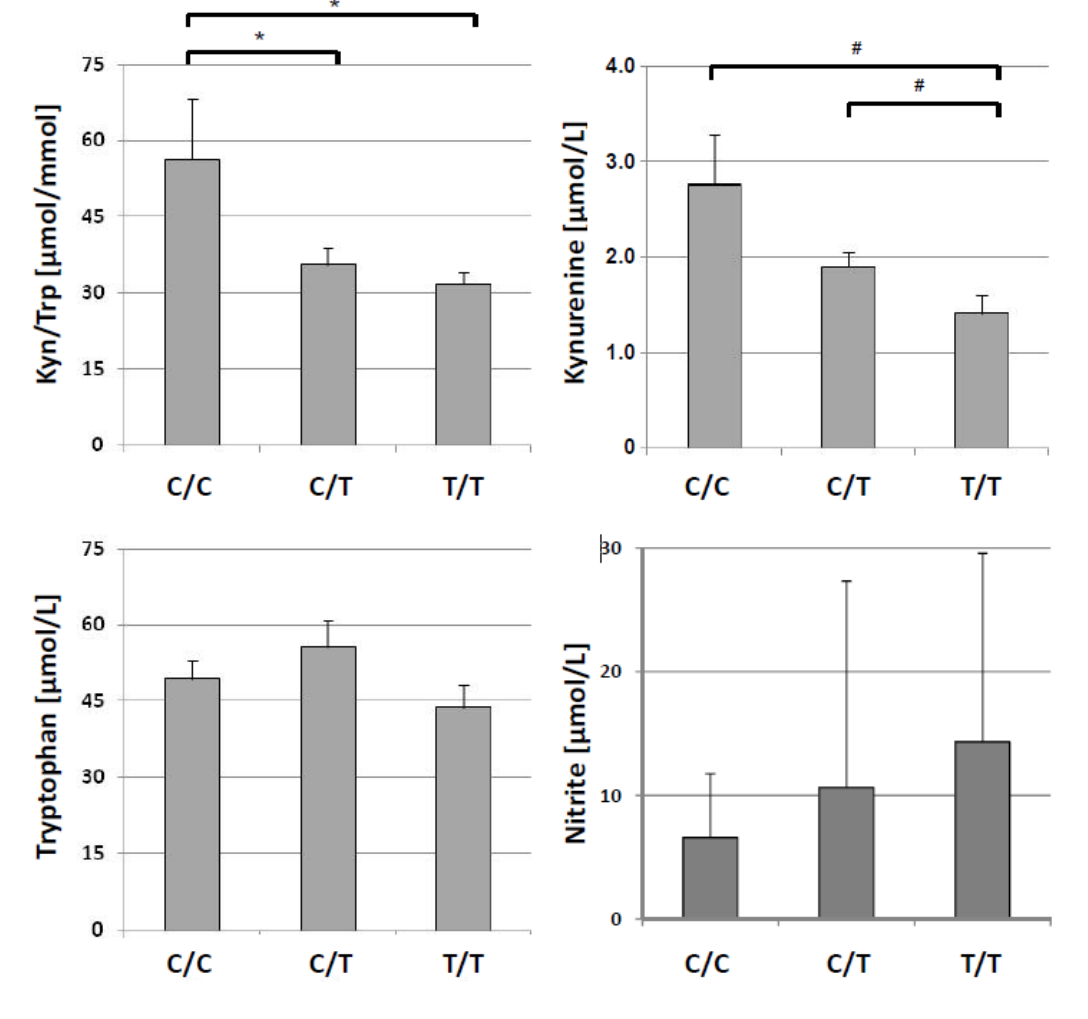
Figure 1. Distribution of concentrations of kynurenine to tryptophan (KYN/TRP, upper left) kynurenine ( upper right ), tryptophan ( lower left ) and nitrite ( lower right ) concentrations in patients with HCV infection split into 3 groups according to IL28B genotypes C/C, C/T and T/T (mean + S.E.M. is shown for each genotype, * p <